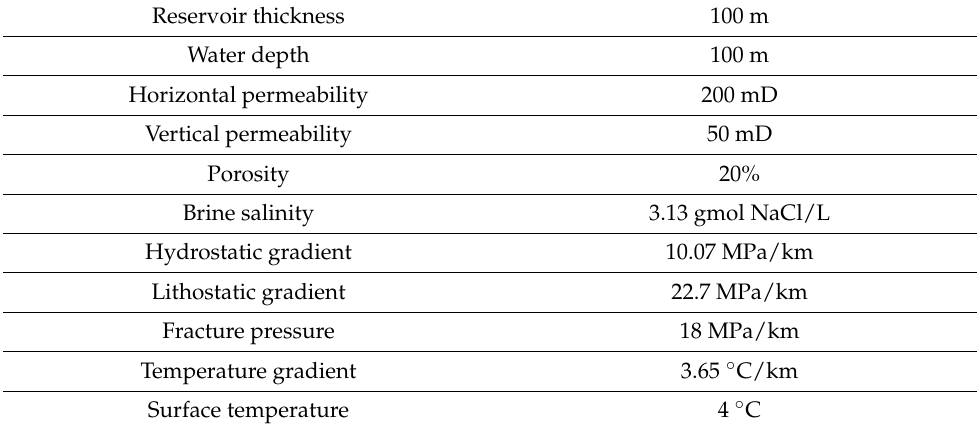
Table 1. Reservoir data and conditions (taken from